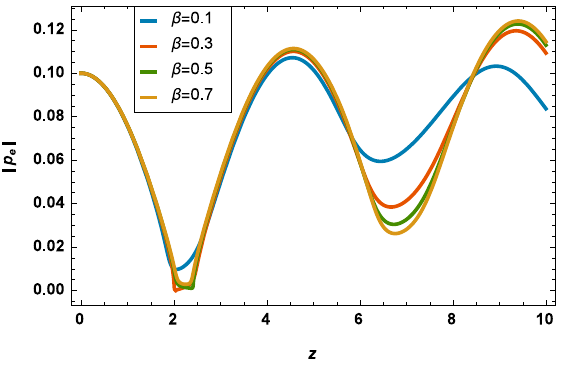
Fig. 11 Pressure along Tapered Tube for Various Values of β with λ a = 0 . 5 , α = 15